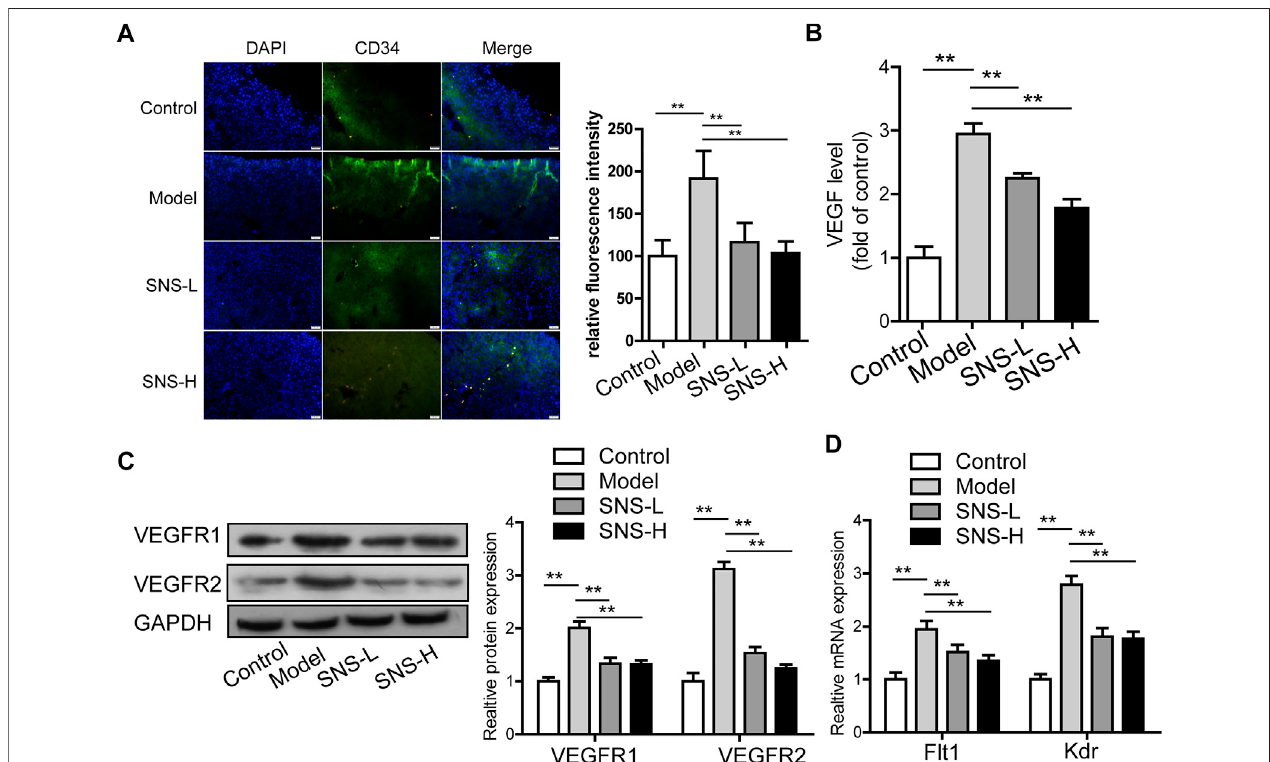
FIGURE 6 | SNS inhibits pathological microvessel and angiogenesis-associated signaling pathways in liver tissue of mice with liver fi brosis. (A) Image analysis of fl uorescenceintensityofCD34(pathologicalmicrovessels)stainedwithIFinhepatictissueofmicewithCCl in liver tissue. (C) Effects ofSNS on VEGFR1 and VEGFR2protein levels in liver tissue. (D) Effectsof SNS on Flt1 and Kdr mRNA levels in liver tissue. Dataare presented as mean ± SD ( n (cid:2) 6). * p < 0.05, ** p < 0.01, *** p < 0.001 compared to control or model